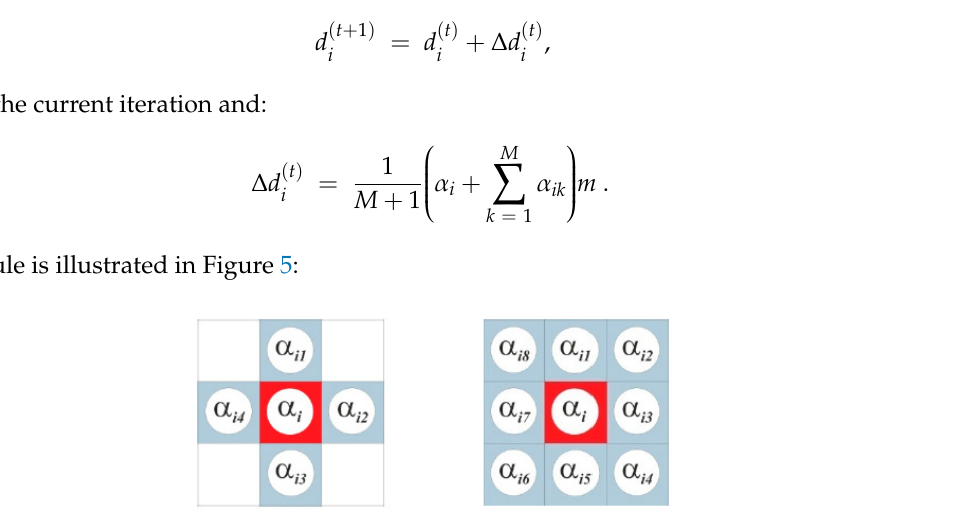
Figure 5. Updating the density of a central cell is based on information gathered among neighboring rectangular cells. The von Neumann ( left ) and Moore ( right ) neighborhood.